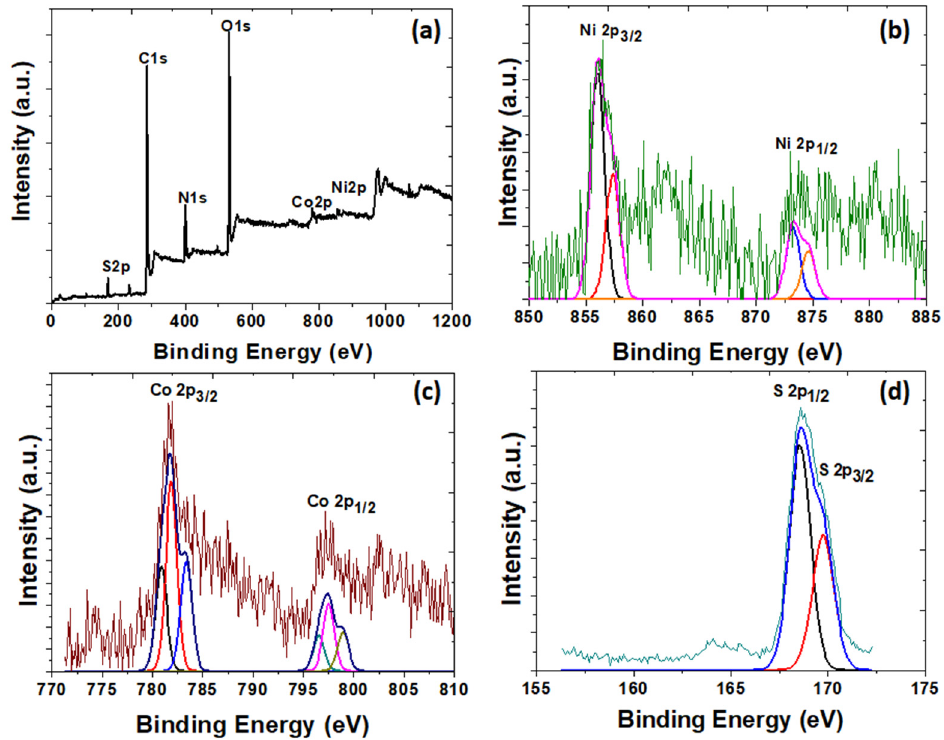
Figure 5. XPS spectra of the as-prepared (NiCo)–S@rGO/oxdCNT composite: ( a ) survey spectra, ( b ) Ni 2p, ( c ) Co 2p and ( d ) S 2p.